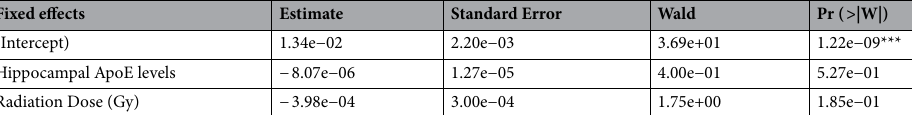
Table 6. Linear generalized estimating equations model results predicting relative hippocampal volumes with ApoE levels in the hippocampus and radiation dose as independent predictors. *** p < 0.001; displayed p -values are uncorrected for multiple comparisons.